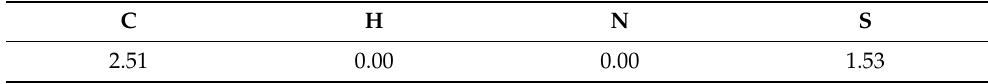
Table 7. Ultimate analyses of the solid residue (wt %).